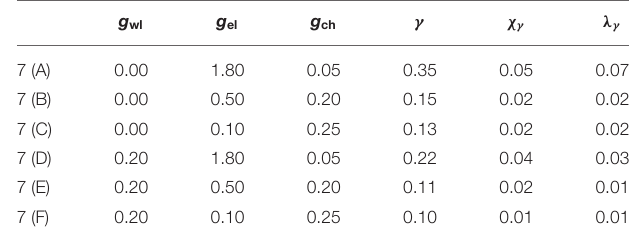
TABLE 1 | Parameter sets used in Figure 7